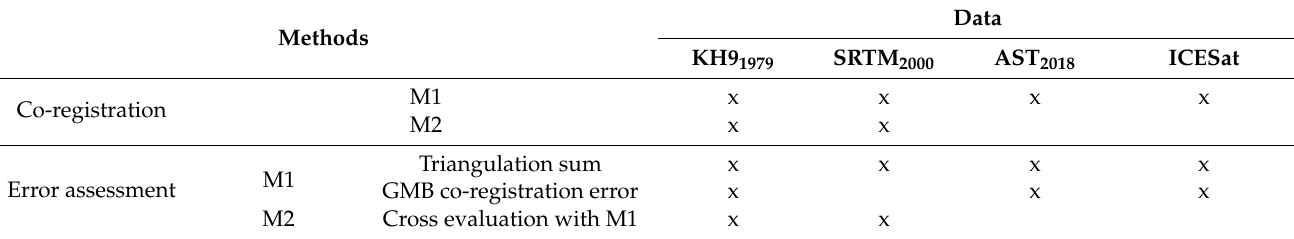
Table 4. Data sources and their utilization in the co-registration procedure and error assessment of M1 and M2.